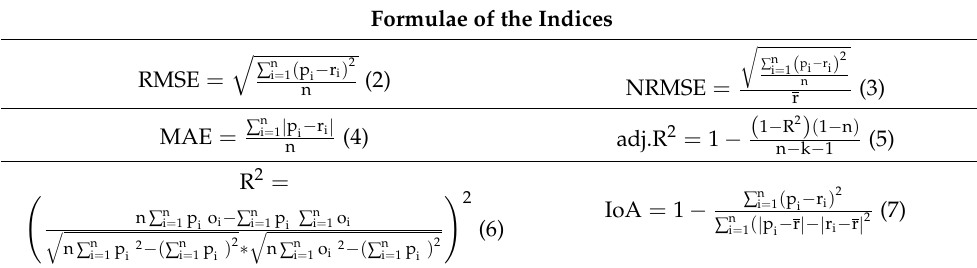
Table 1. The statistical measures employed to evaluate the performance of the regression models. Formulae of the